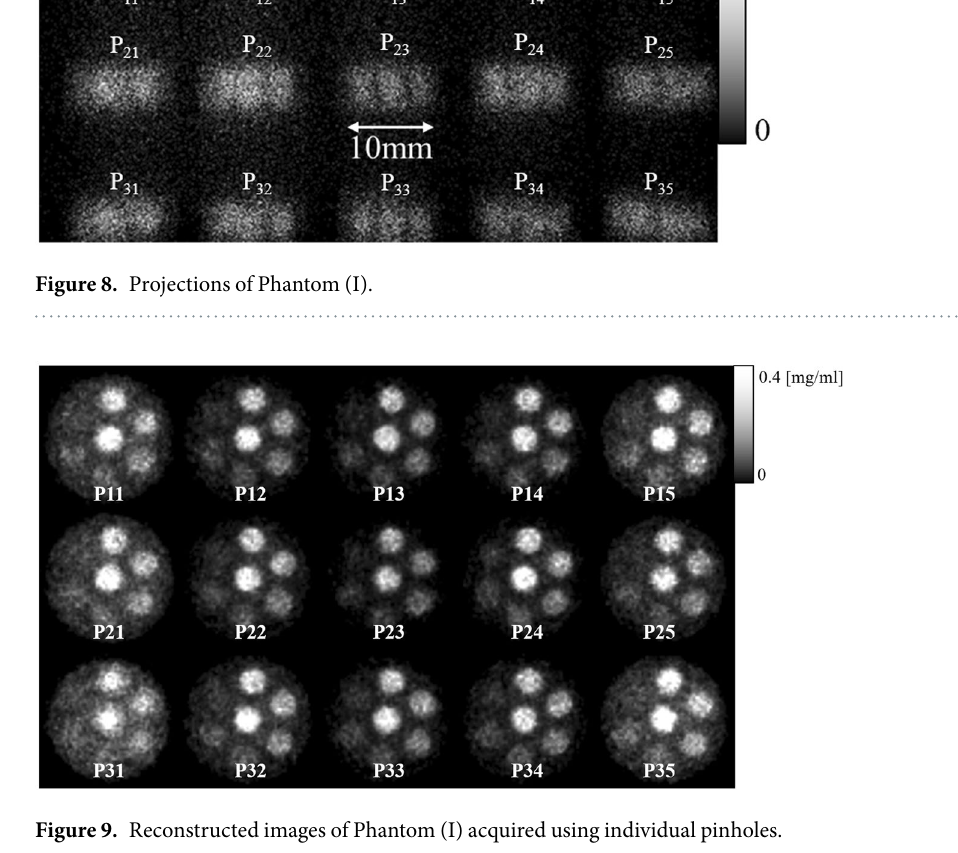
Figure 9. Reconstructed images of Phantom (I) acquired using individual pinholes.